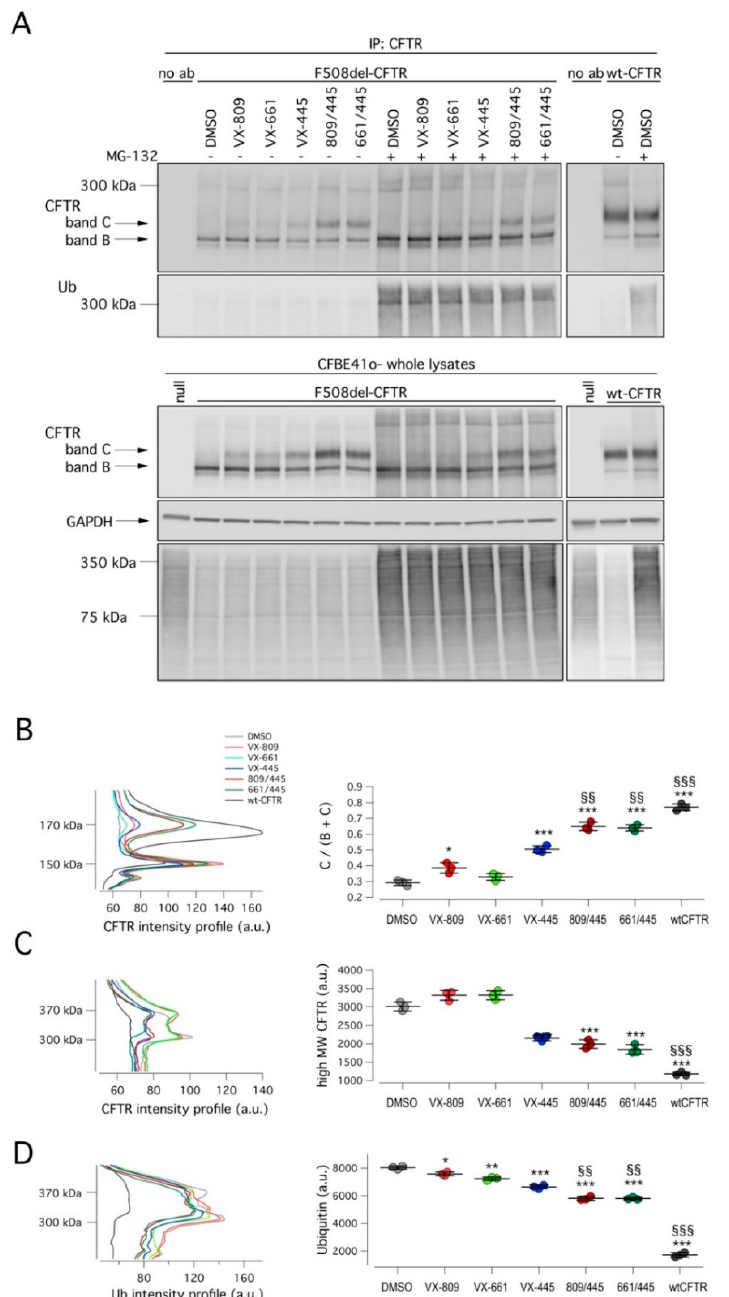
Figure 4. Effect of VX-445-based treatments on mutant CFTR ubiquitylation. ( A ) Biochemical analysis of CFTR ubiquitylation and expression pattern in CFTR immunoprecipitates from wild- type or F508del-CFTR expressing CFBE41o- cells after 24 h treatment with vehicle alone (DMSO), or (for mutant CFTR only) VX-445 (3 µ M), VX-809 (3 µ M), or VX-661 (10 µ M) as single agents or combinations in the absence or in the presence of the proteasome inhibitor MG-132 (10 µ M; last 4 hr) to block proteasomal degradation. For comparison, whole lysates derived from CFBE41o- cells not expressing CFTR (null cells) are also shown as controls for antibody specificity. ( B – D ) Representative density profiles (left graphs) and corresponding quantification (right graphs) of CFTR and ubiquitin in the absence ( B ) or in the presence of MG-132 ( C , D ) Quantification of the density profiles was performed by integrating the profile curves in the selected intervals of molecular weight (see left graphs). *, p < 0.05; **, p < 0.01; ***, p < 0.001 vs. DMSO; §§, p < 0.01; §§§, p < 0.001 vs. VX-445